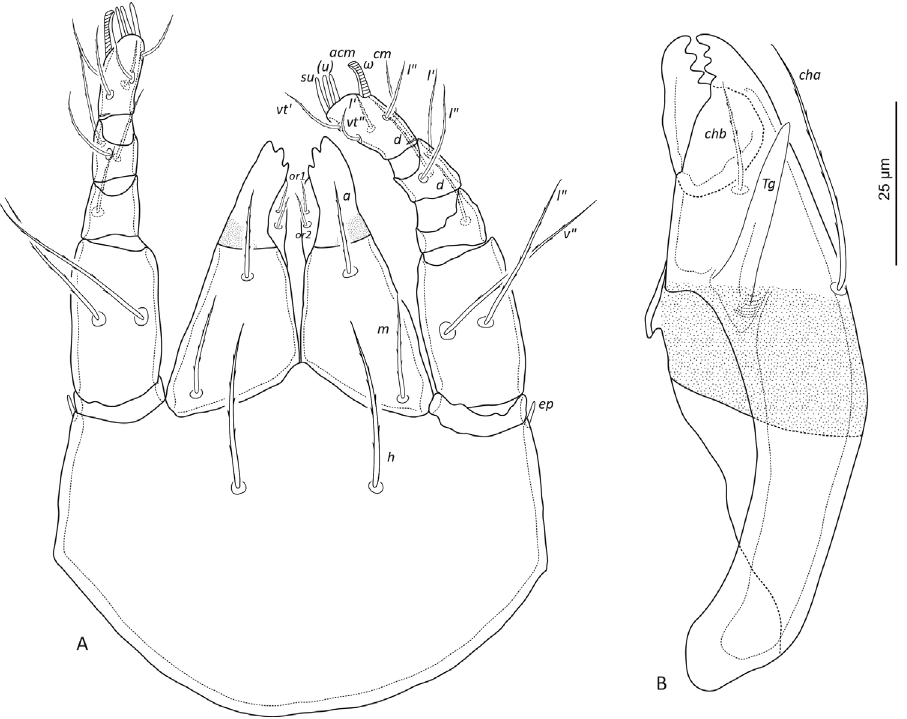
Figure 5. Female Paraleius leahae sp. n. A ventral view of subcapitulum B chelicerae, paraxial view.